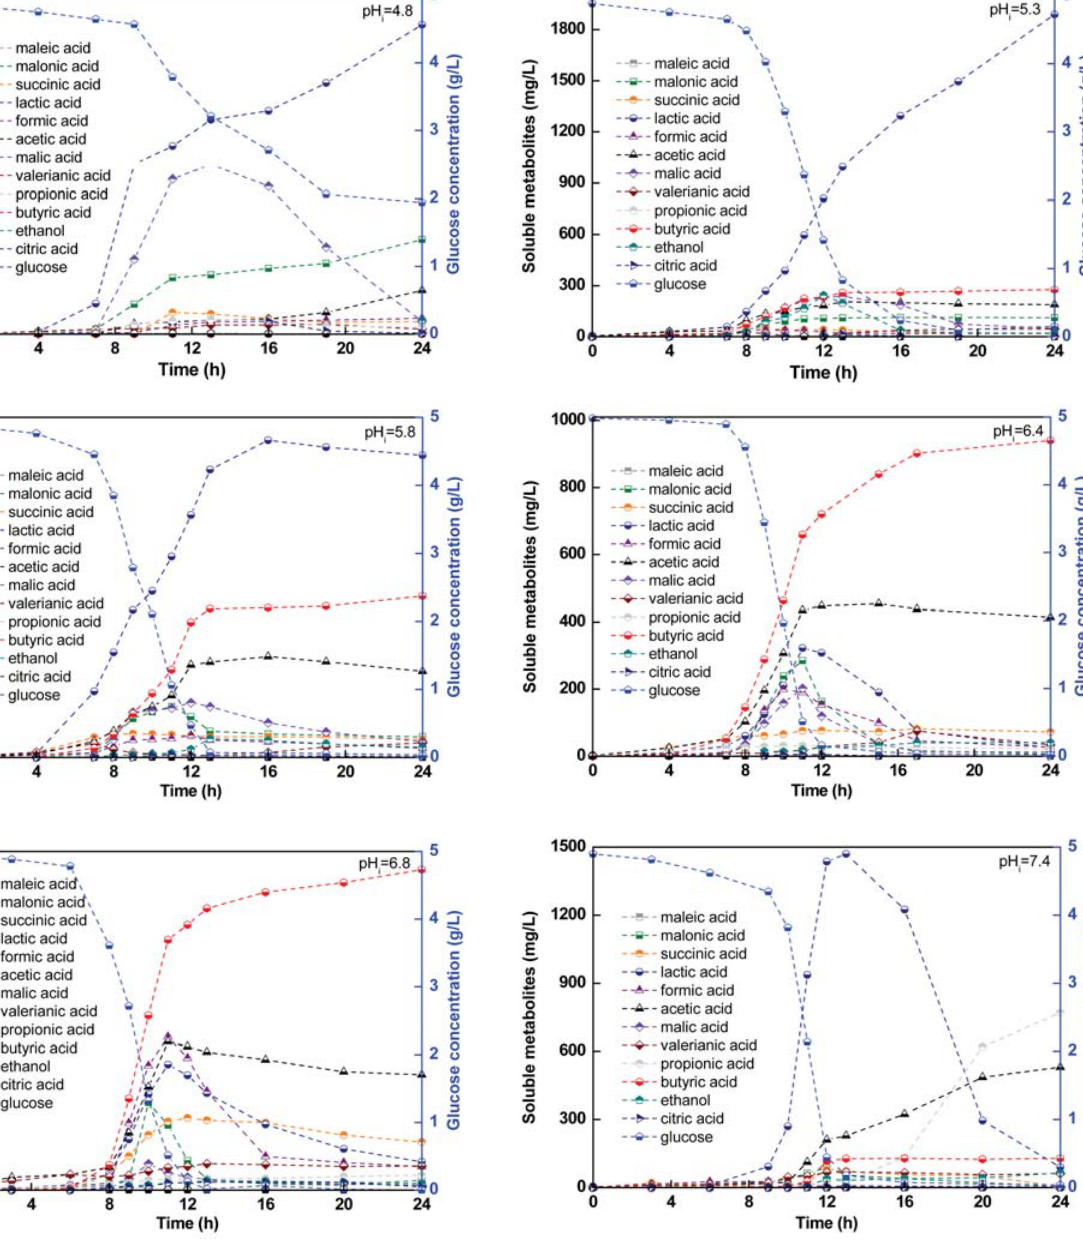
Figure 2. Time course profiles of soluble metabolites distribution (%) and glucose degradation for different initial pH values of fermentation broth. Lines show